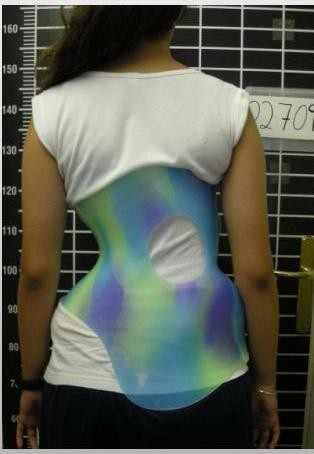
(Short brace) (Lumbo-sacral brace with a main thoracic counter-pad).